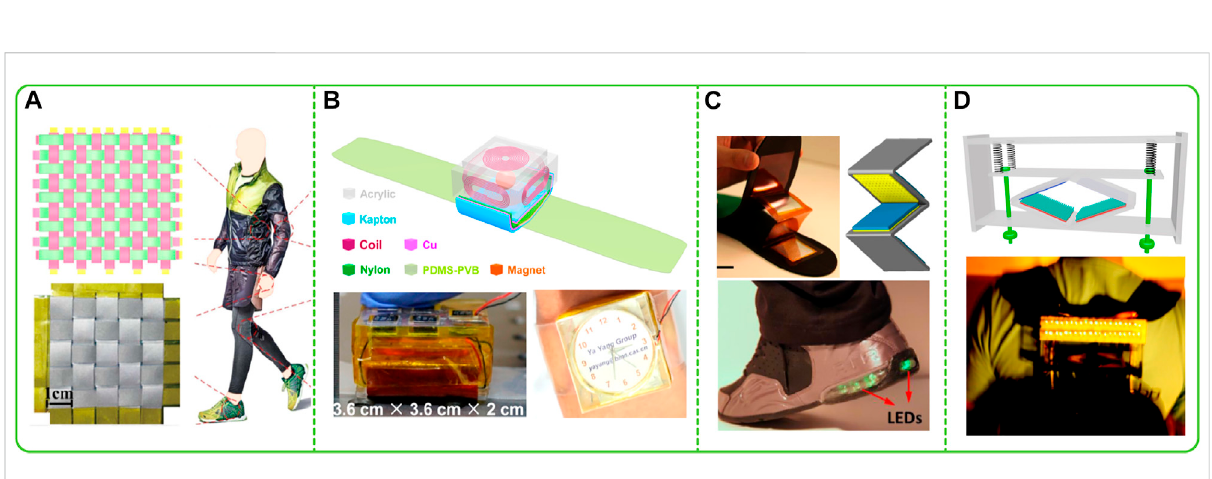
FIGURE 4 Triboelectric EH from human motion. (A) Model and photograph of DTET (Tian et al., 2017). (B) Schematic diagram and photograph of the hybridized nanogenerator (Quan et al., 2015). (C) Structural design and implementation of the in-shoe TENG (Zhu et al., 2013). (D) Sketch and photograph of the proposed self-powered backpack (Yang et al.,